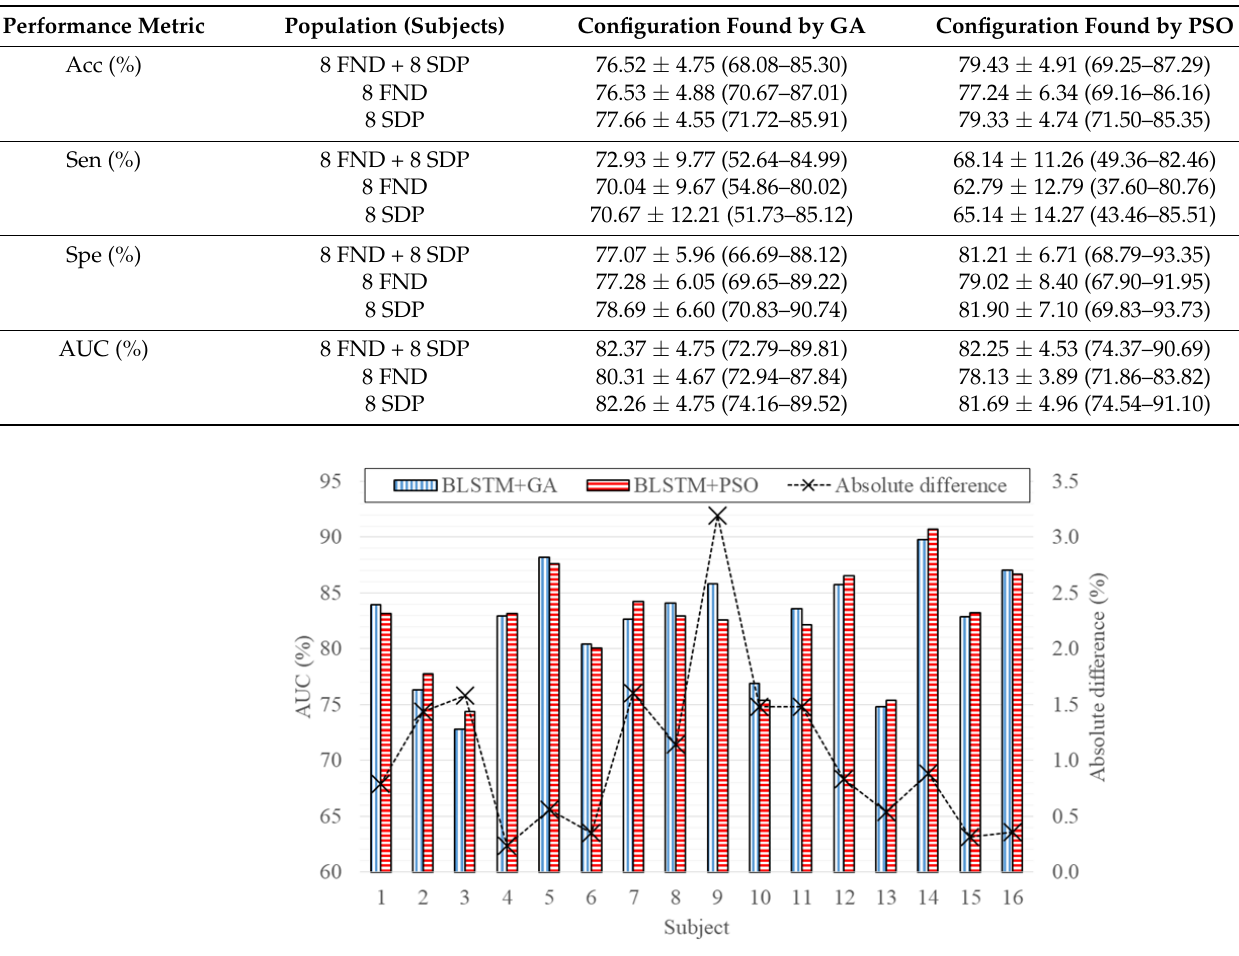
Figure 4. AUC estimation using LOO for the models optimized by GA (BLSTM + GA) and PSO (BLSTM + PSO), depicting the absolute difference between the performance for each examined subject (model evaluating the 16 subjects).